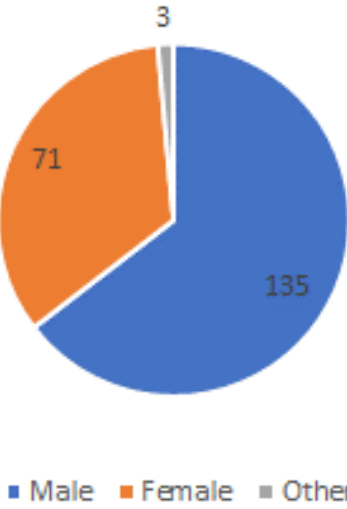
Figure 1. Respondents by gender.